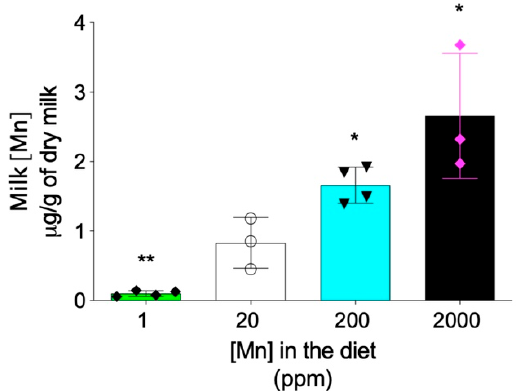
Figure 6. Maternal breast milk manganese content can be altered by dietary intervention. Zip14 + / − mating mice at 8 – 9 weeks old were fed diets containing 1 ppm, 20 ppm, 200 ppm, or 2000 ppm of manganese during breeding and lactation periods (for a total of ~6 – 7 weeks). Milk manganese contents were analyzed by ICP-MS ( n = 3 – 4/group). Data were expressed as mean ± S.D. and statistical analysis was performed using one-way ANOVA, followed by the Bonferroni post-hoc test. * p < 0.05; ** p < 0.01, compared with the control group (20 ppm).